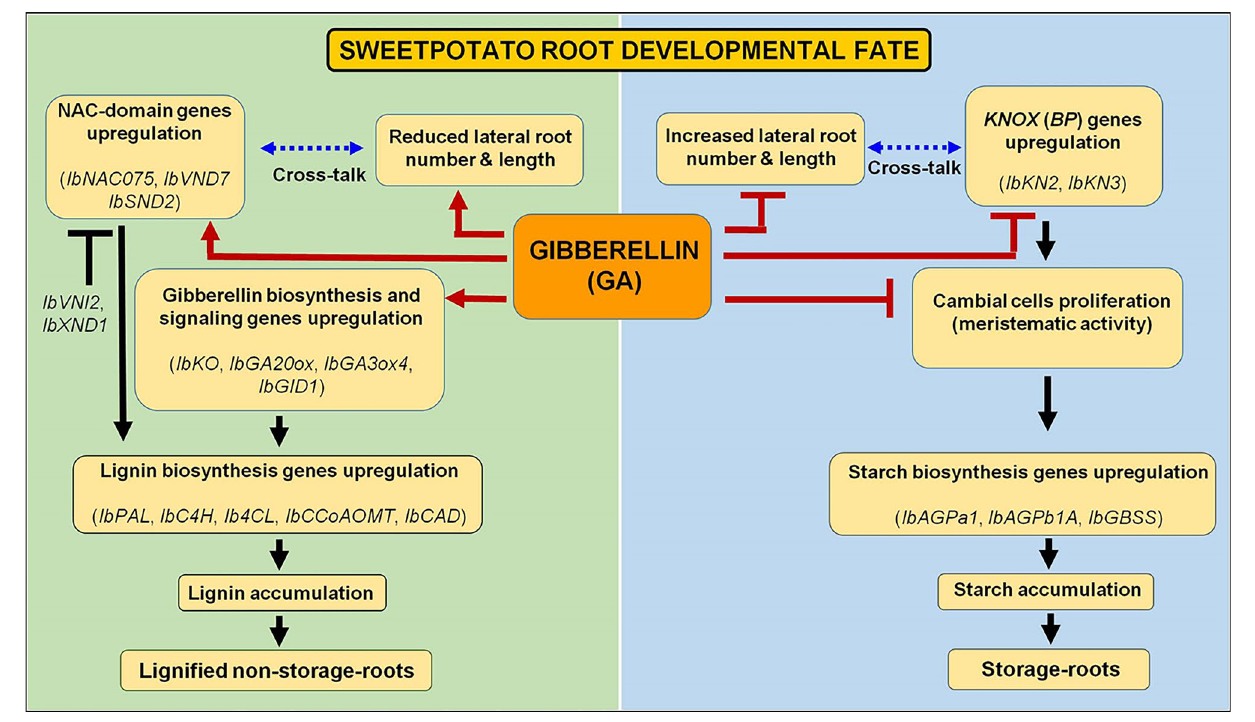
FiGURe 13 | Schematic presentation showing a central role for gibberellin (GA) in formation of either lignified non-storage roots or storage roots. Gibberellin enhances xylem development and proliferation, and lignin accumulation, following the upregulation of NAC-domain genes (regulators of vascular development), and lignin biosynthesis genes, together with reducing root system architecture and lateral root development, bringing about the formation of lignified non-storage roots. At the same time, GA inhibits transcript levels of KNOX genes and of genes involved in starch biosynthesis, followed by inhibition of starch accumulation, causing inhibition of the developmental pathway that brings about storage-root formation. Genes considered significant to the respective processes are indicated.